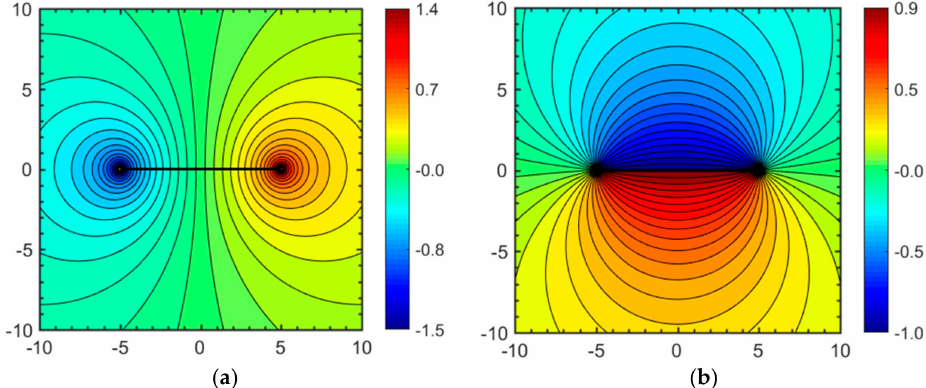
Figure 11. Potential function ( a ) and stream function ( b ) as in Figure 10. Strength of line dipole ( m ) = 20 m 3 · s − 1 and z a = − 5 and z b =